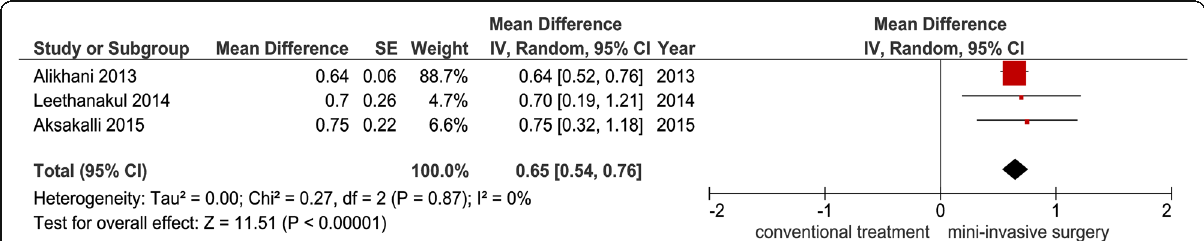
Fig. 4 Forest plot of the comparison between minimally invasive surgical procedures and conventional treatment for the canine retraction amount at 1 month